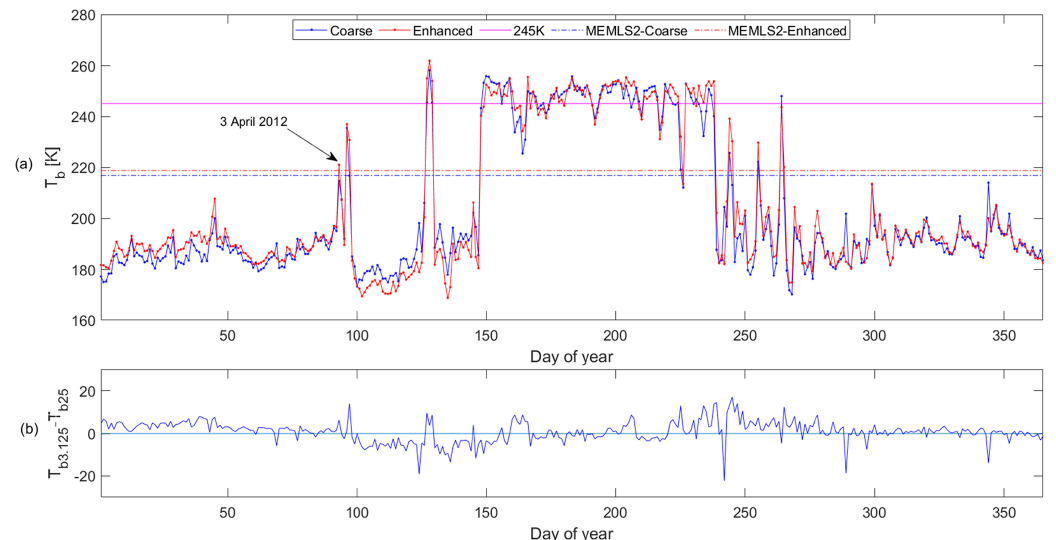
Figure 2. (a) Time series of T b at 37GHz, horizontal polarization, for the year 2012 for the pixel containing the Swiss Camp site in the case of the coarse (blue) and enhanced (red) products. Threshold values, shown as horizontal lines, are obtained from two approaches considered in this study: 245K and MEMLS. (b) The difference between the 3.125km and the 25km T b time series for the same pixel (mean of 0.895K and standard deviation of 4.89K).